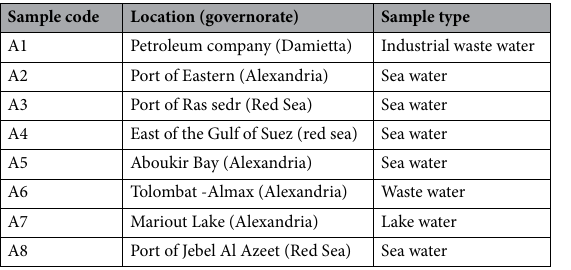
Table 6. Sample code, location (Governorate) and sample type used for isolation of metal NPs forming